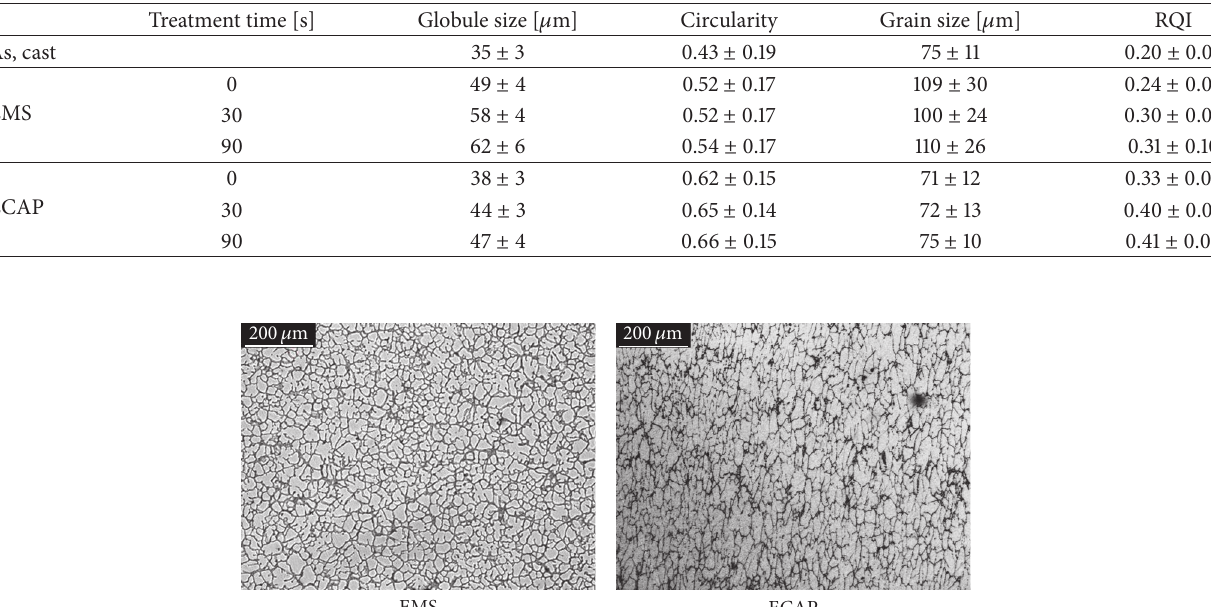
Table 3: Microstructural characterization of the Al-4.0wt%Si-2.5wt%Cu alloy.